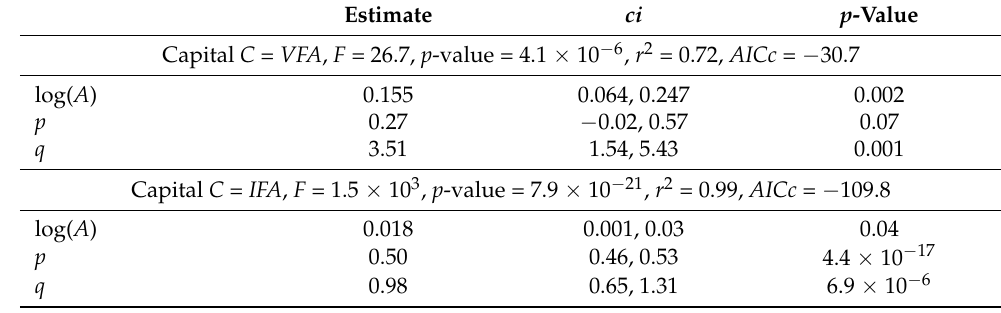
Table 2. Estimates of Cobb-Douglas PF parameters (1), F-statistics ( F ), adjusted coefficients of determination ( r 2 ), values of the Akaike information criterion for small samples ( AICc ), 95% confidence intervals ( ci ), p-values ( p -value) calculated based on the data for 2000–2020 using VFA and IFA as capital.